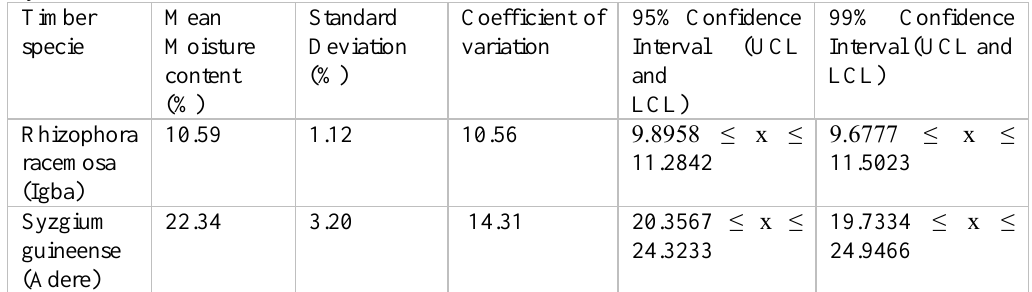
Summary of Moisture content